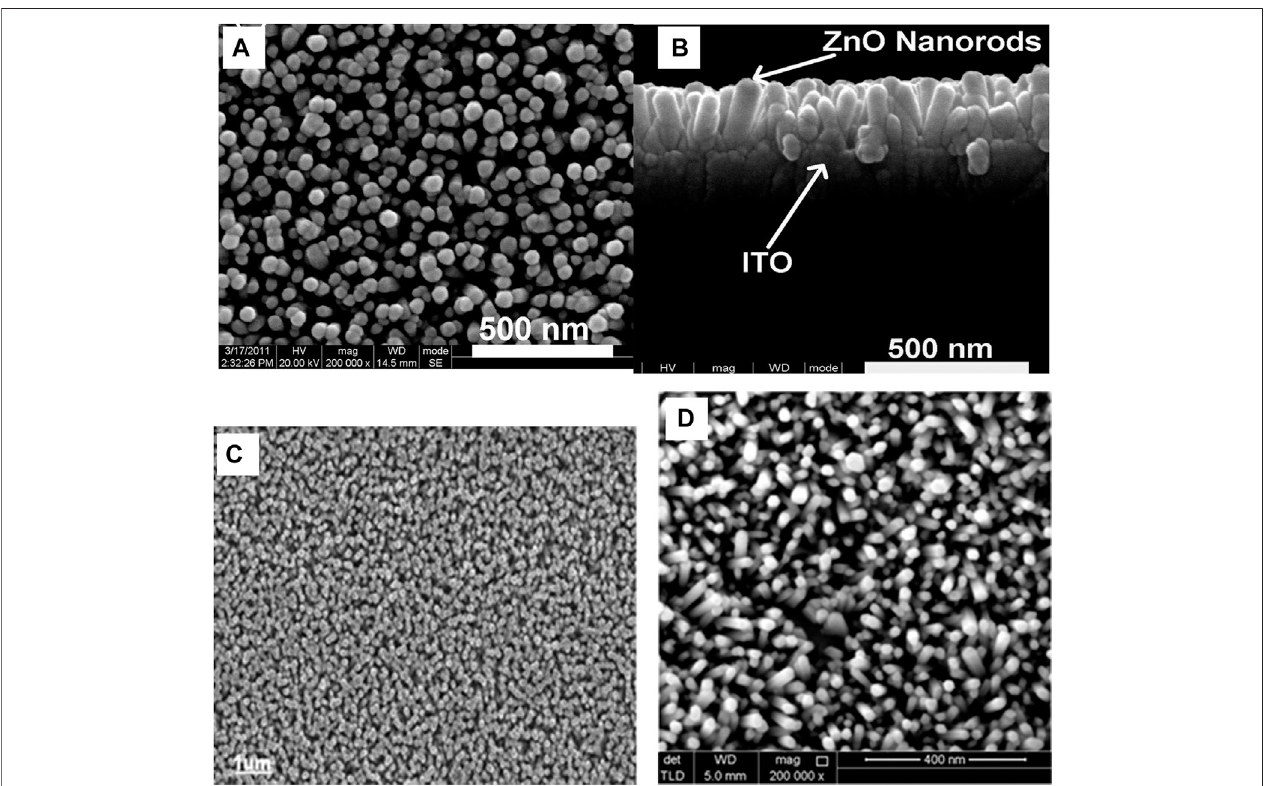
FIGURE 7 | (A) high-resolution top-view FESEM images of the densely packed aligned ZNRA, and (B) cross-sectional FESEM images of the ZNRA. (Yuan, 2015); (C) Field emission scanning electron micrographs (SEM) of a ZnO nanorods grown at 50 ° C on TFB/PFO polymer layers on top of PEDOT:PSS/plastic fl exible substrate (Zainelabdin et al., 2010), (D) Surface FESEM image of the ZnO nanorods on PEN substrate (Shabannia and Hassan, 2014).